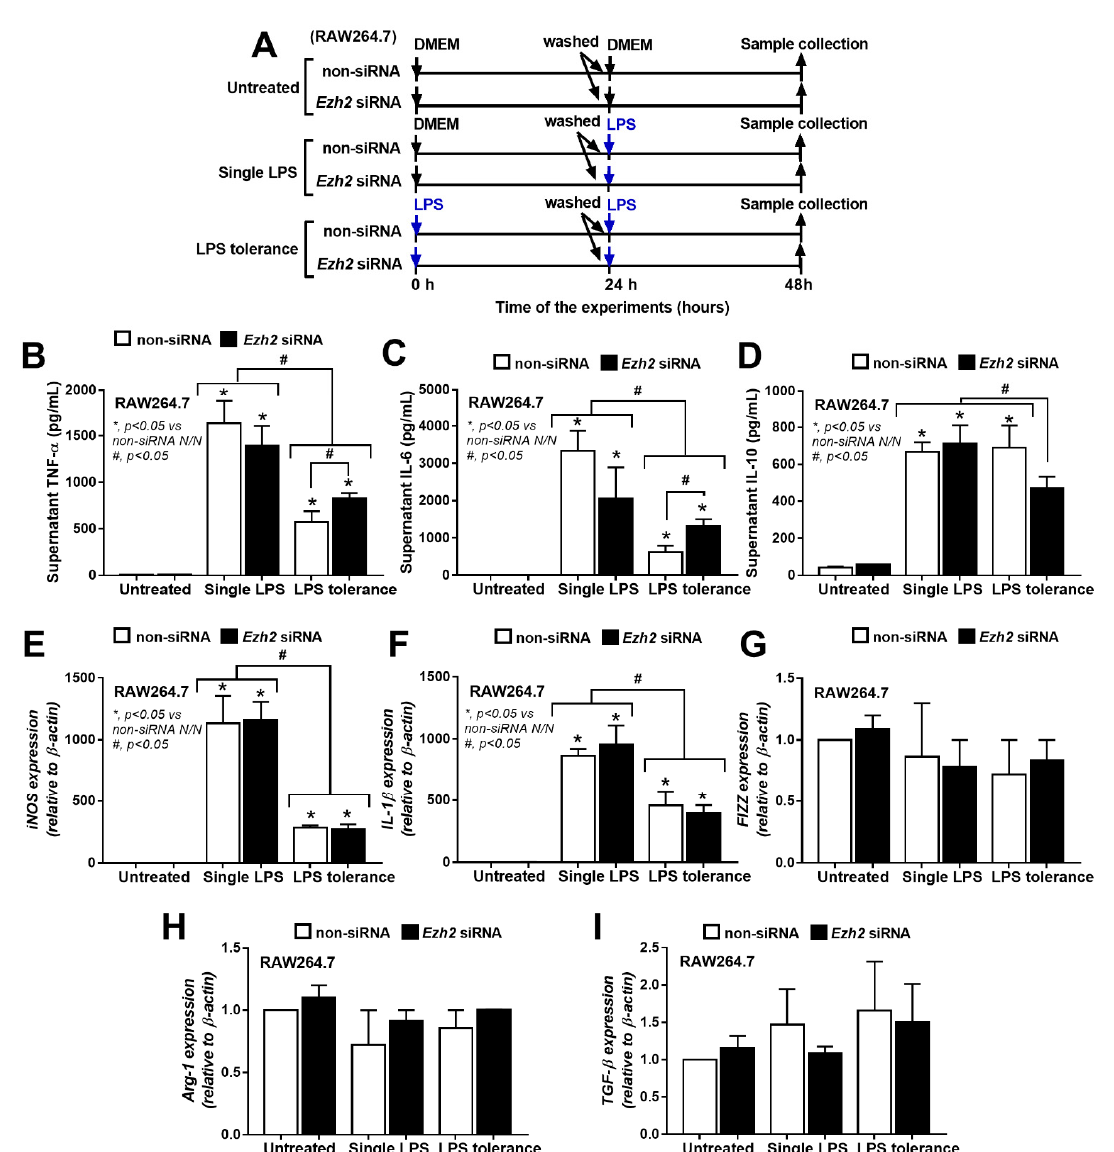
Figure 2. The schema of the experiments in a murine macrophage cell line (RAW264.7) with the silencing of Ezh2 gene using small interfering RNA ( Ezh2 siRNA) or the control siRNA (non-targeting pool siRNA; non-siRNA) and activated by lipopolysaccharide (LPS) in a single protocol (N/LPS) which began with the culture media followed by LPS 24 h later or LPS tolerance (LPS/LPS) by two LPS stimulations, or control (N/N) using the culture media incubation twice ( A ). The characteristics of these macrophages with different protocols as indicated by supernatant cytokines (TNF- α , IL-6, and IL-10) ( B – D ), expression of pro-inflammatory genes of M1 polarization (iNOS and IL-1 β ) ( E , F ), and anti-inflammatory genes of M2 polarization (Fizz-1, Arg-1, and TGF- β ) ( G – I ) are demonstrated. Triplicated independent experiments were performed. Mean ± SEM is presented with the one-way ANOVA followed by Tukey’s analysis (*, p < 0.05 vs. non-siRNA N/N and #, p < 0.05). 2.3. Characteristics of Macrophages from Ezh2 Control (Ezhfl/fl; LysM-Cre − / − ) or Ezh2 Null (Ezhfl/fl; LysM-Crecre cre/ − ) Mice after a Single LPS Stimulation and LPS Tolerance To investigate the impact of Ezh2 on LPS stimulation, macrophages from mice with conditional Ezh2 deletion using the LysM-Cre system were used (Figure 3A). Similar to the Ezh2 silencing with siRNA, the severity of LPS tolerance of macrophages from Ezh2 null mice ( Ezh fl/fl ; LysM-Cre cre/ − ) was lower than LPS tolerance in the litter mate